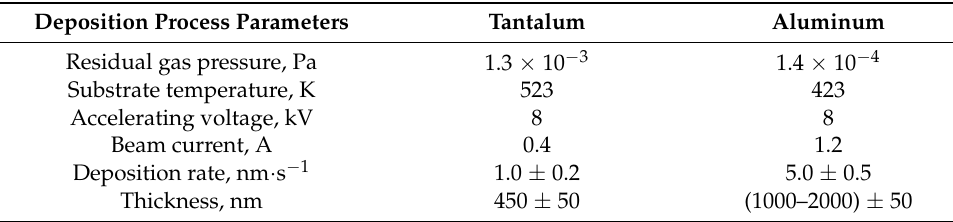
Table 1. The deposition parameters for the tantalum and aluminum thin films.